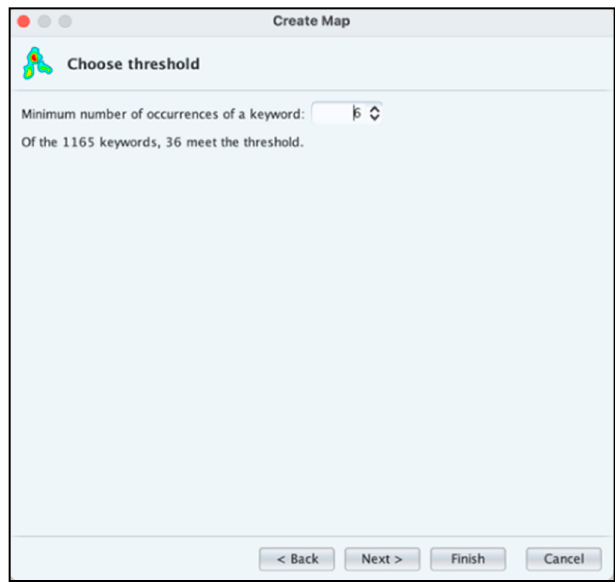
Figure A3. Selected “co-occurrence” on the left first then select “all keywords” on the right.